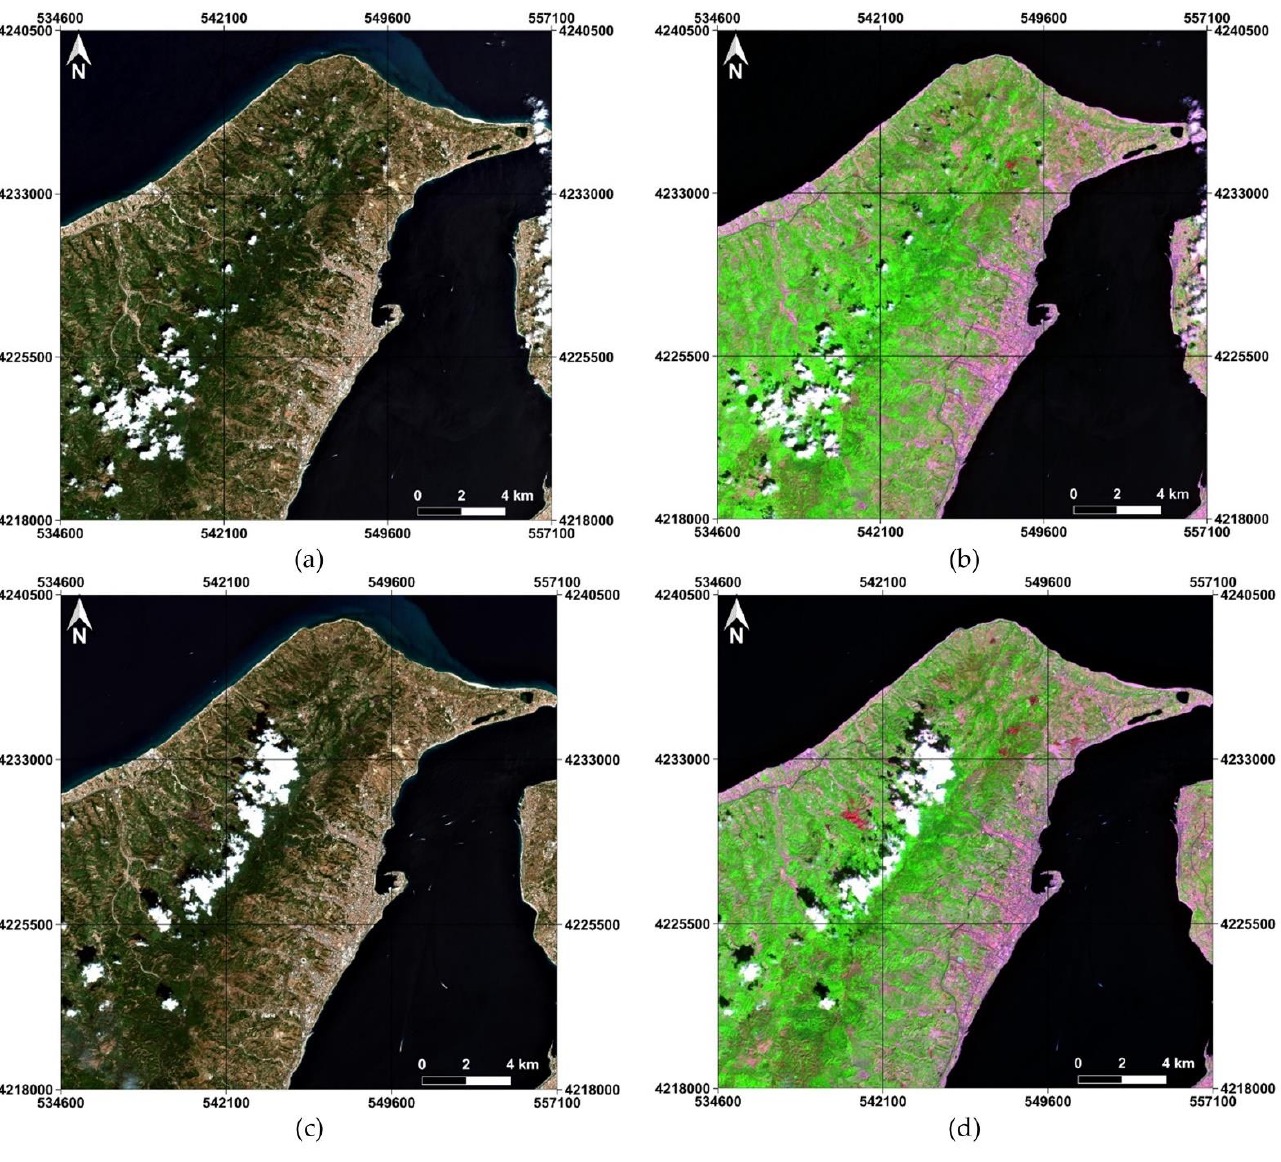
Figure 2. Satellite image in UTM projection of the scene in pre- and post-fire scenario: color repre- sentation (composite bands 4-3-2) pre-fire ( a ); false color representation (composite bands 12-8A-4) pre-fire ( b ); color representation (composite bands 4-3-2) post-fire ( c ); false color representation (composite bands 12-8A-4) post-fire ( d ).